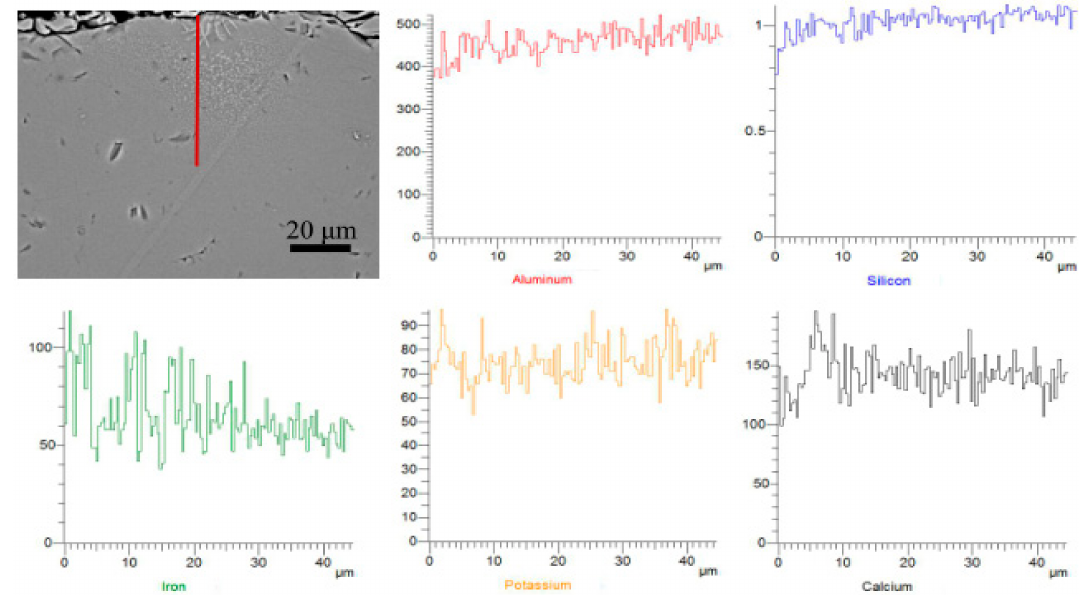
Figure 7. The element map distribution results of the surface glaze: ( a ) SEM micrograph, ( b ) Al, ( c ) Si, ( d ) Fe, ( e ) K, and ( f ) Ca.